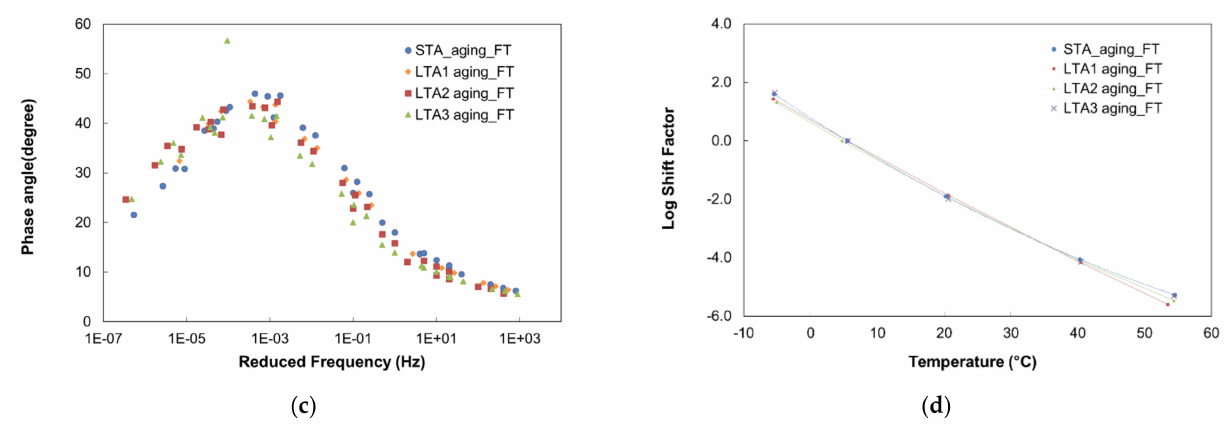
Figure 11. Dynamic modulus test results of WMA after moisture damage for each stage of aging: ( a ) dynamic modulus master curve (semi-log scale), ( b ) dynamic modulus master curve (log-log scale), ( c ) phase angle master curve, and ( d ) shift factor.